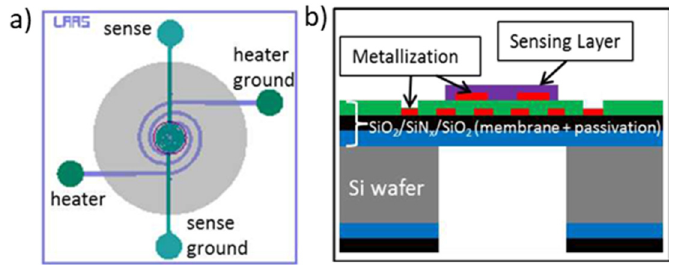
Figure 1. ( a ) Top view of the microhotplate; ( b ) Cross section of the sensor.